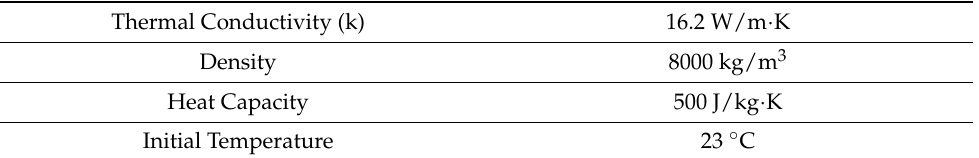
Figure 3. The picture of the specimen used in the study: ( a ) front side coated with black paint, and ( b ) back side with flat-bottomed holes. Table 1. The material properties of the STS304 plate.